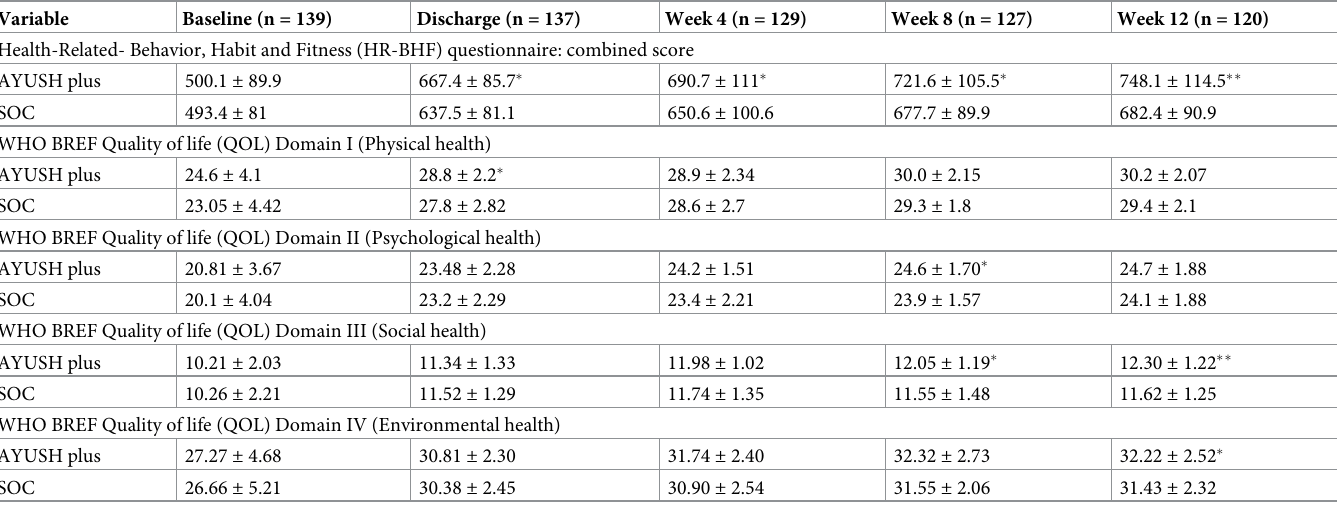
Table 4. Quality of life questionnaires and health scores (HR-BHF and WHO QOL Bref) in the two study groups (n = 139).